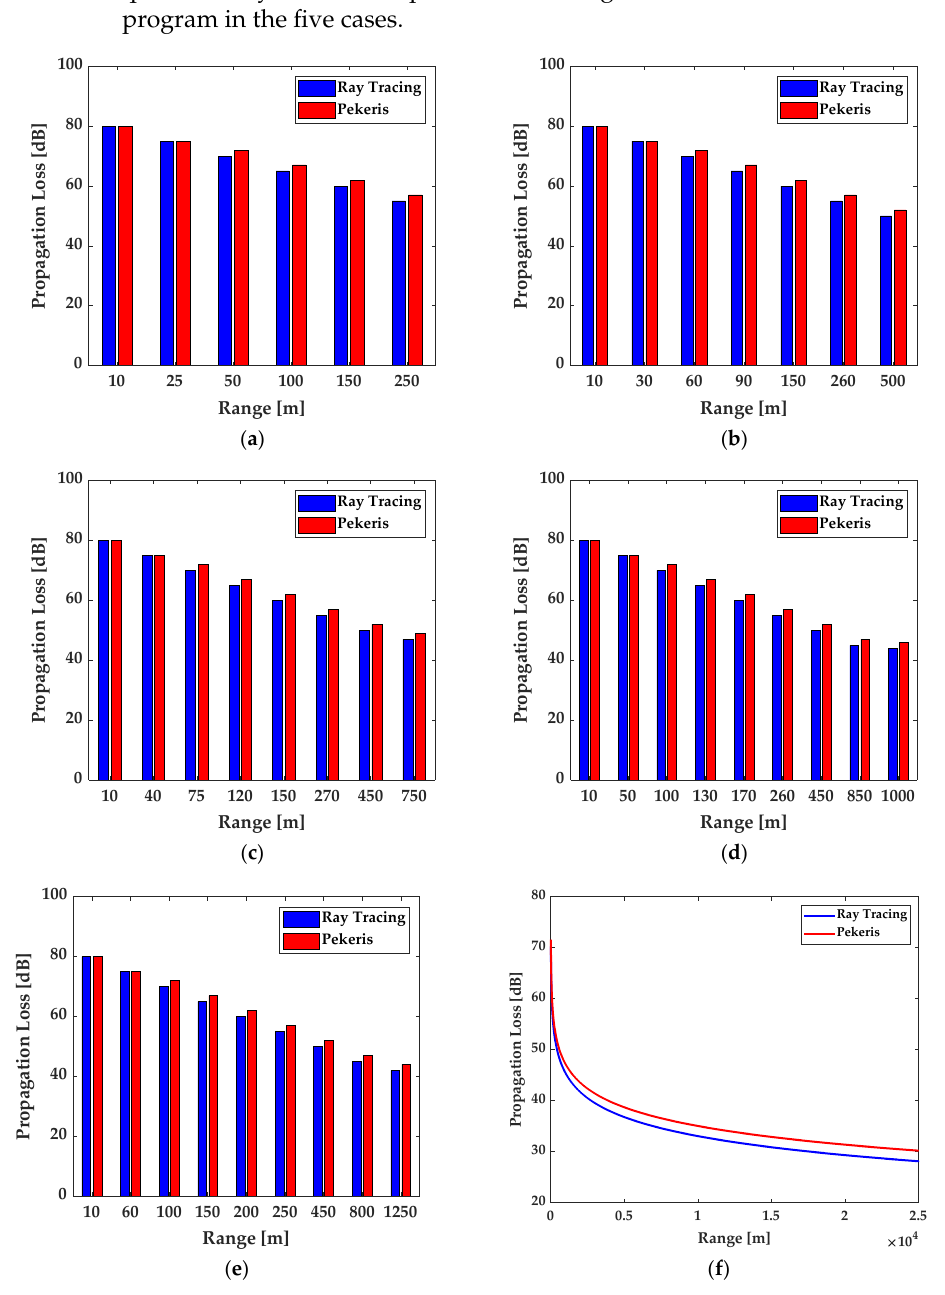
Figure 8. Trend of the propagation loss at different conditions compared with the Pekeris model predictions: ( a ) 250 m; ( b ) 500 m; ( c ) 750 m; ( d ) 1000 m; ( e ) 1250 m; ( f ) range up to 25 km.